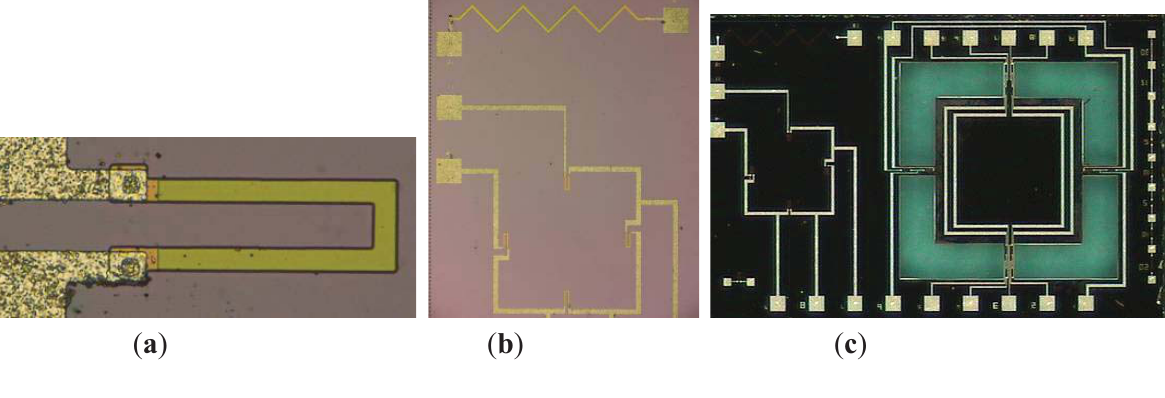
Figure 6. The digital microscopy of finished sensor chip: ( a ) the resistor of the pressure sensor; ( b ) the temperature sensor and the absolute pressure sensor; ( c ) the integrated sensor